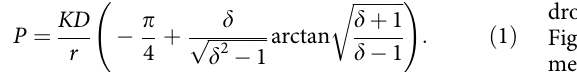
Figure 4 | Oil Permeability P . ( a ) The permeability is a function of the centre-to-centre distance between the droplets d c normalized by the droplet diameter 2 r . Experimental data are fitted using equation (1) (see Supplementary Fig. 2 and Supplementary Note 2) to obtain the diffusion coefficient of the dye in the oil-surfactant mixture using the values of K determined independently ( b ). We obtain D ¼ 7.6 (cid:3) 10 (cid:2) 9 cm 2 s (cid:2) 1 (5% surfactant), D ¼ 7.8 (cid:3) 10 (cid:2) 9 cm 2 s (cid:2) 1 (2% surfactant), D ¼ 8.2 (cid:3) 10 (cid:2) 9 cm 2 s (cid:2) 1 (1% surfactant). The value indicates that transport is mediated by surfactant aggregates affect the partitioning coefficient of the organic molecule between both the phases (error bars are standard deviation over three experiments); conc,